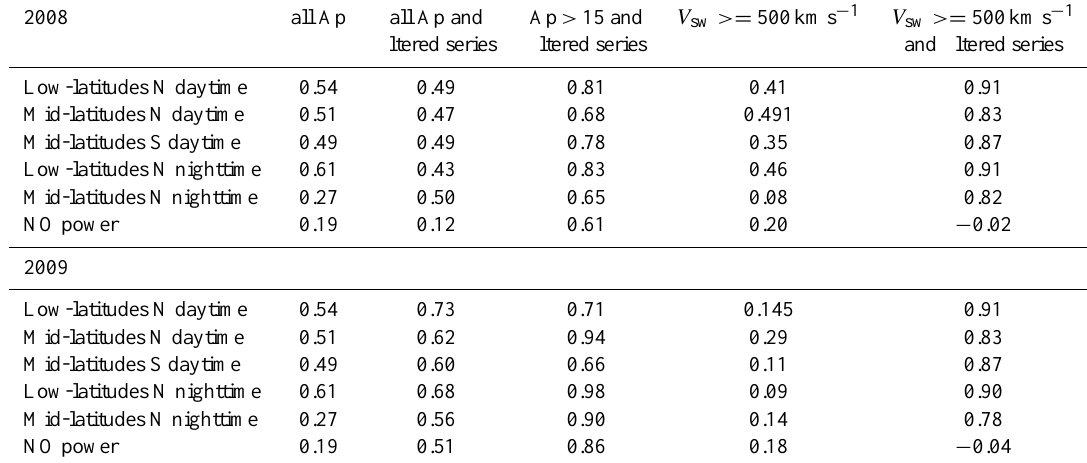
Table 2. Correlation between VTEC and NO emission power with Ap index and solar wind speed in 2008–2009. See text for details. 2008 all Ap all Ap and Ap > 15 and V sw > = 500kms − 1 V sw > = 500kms − 1 filtered series filtered series and filtered series Low-latitudes N daytime 0.54 Mid-latitudes N daytime